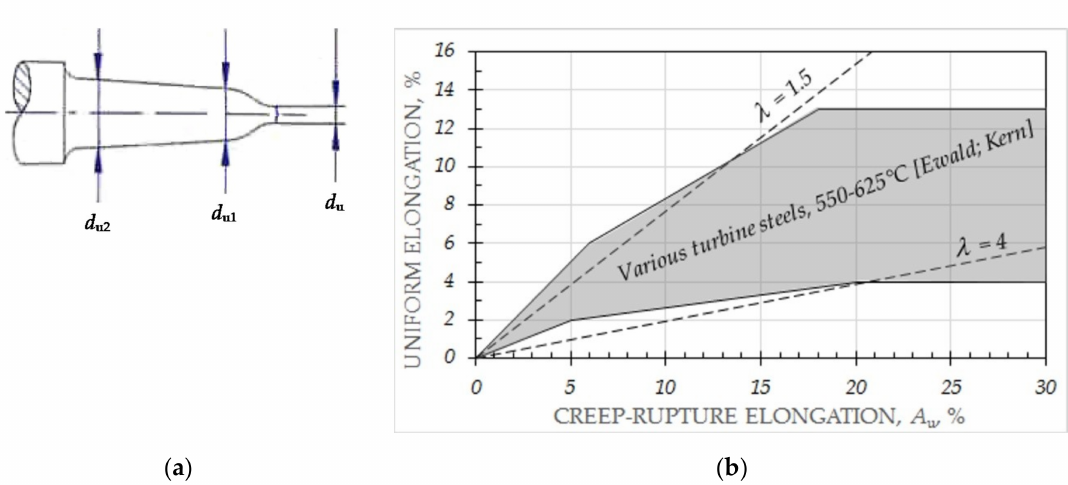
Figure 2. ( a ) Quantities required for the determination of uniform elongation at rupture, ( b ) Schematic of relationship between uniform elongation ( A u,u ) and rupture elongation ( A u , ε cu ) for various turbine steels at temperatures in the range of 550–625 ◦ C [15] (the significance of the λ lines is discussed